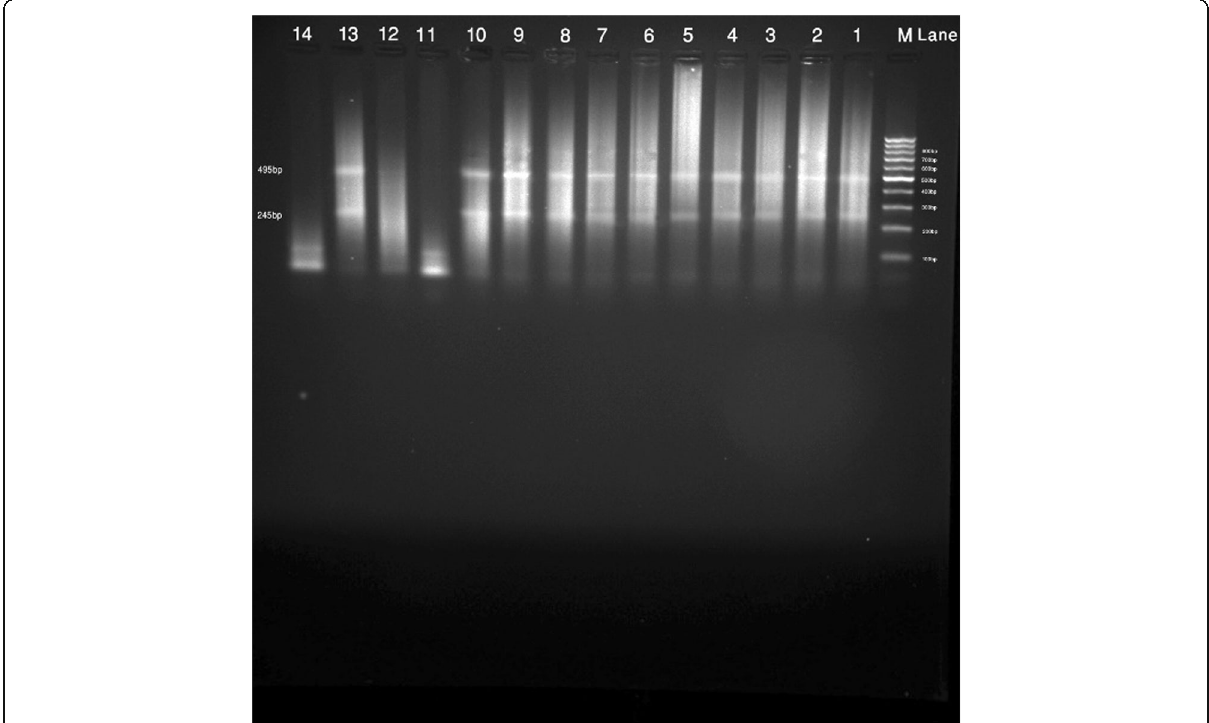
Fig. 3 Representative gel picture showing the PCR-RFLP analysis of TaqI VDR gene polymorphism on ethidium bromide-stained 2% agarose gel. M, marker (100 bp DNA ladder); lanes 1, 2, 3, 4, 5, 6, 7, 8, 9, 10, and 13 represent no polymorphism (AA genotype; 495 and 245 bp